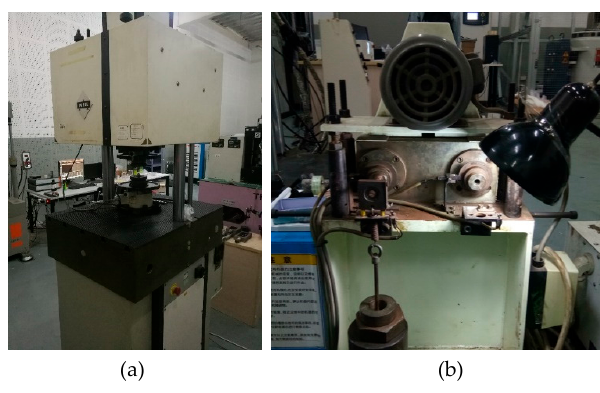
Figure 3. Test equipment: ( a ) Rumul; ( b ) Horks.